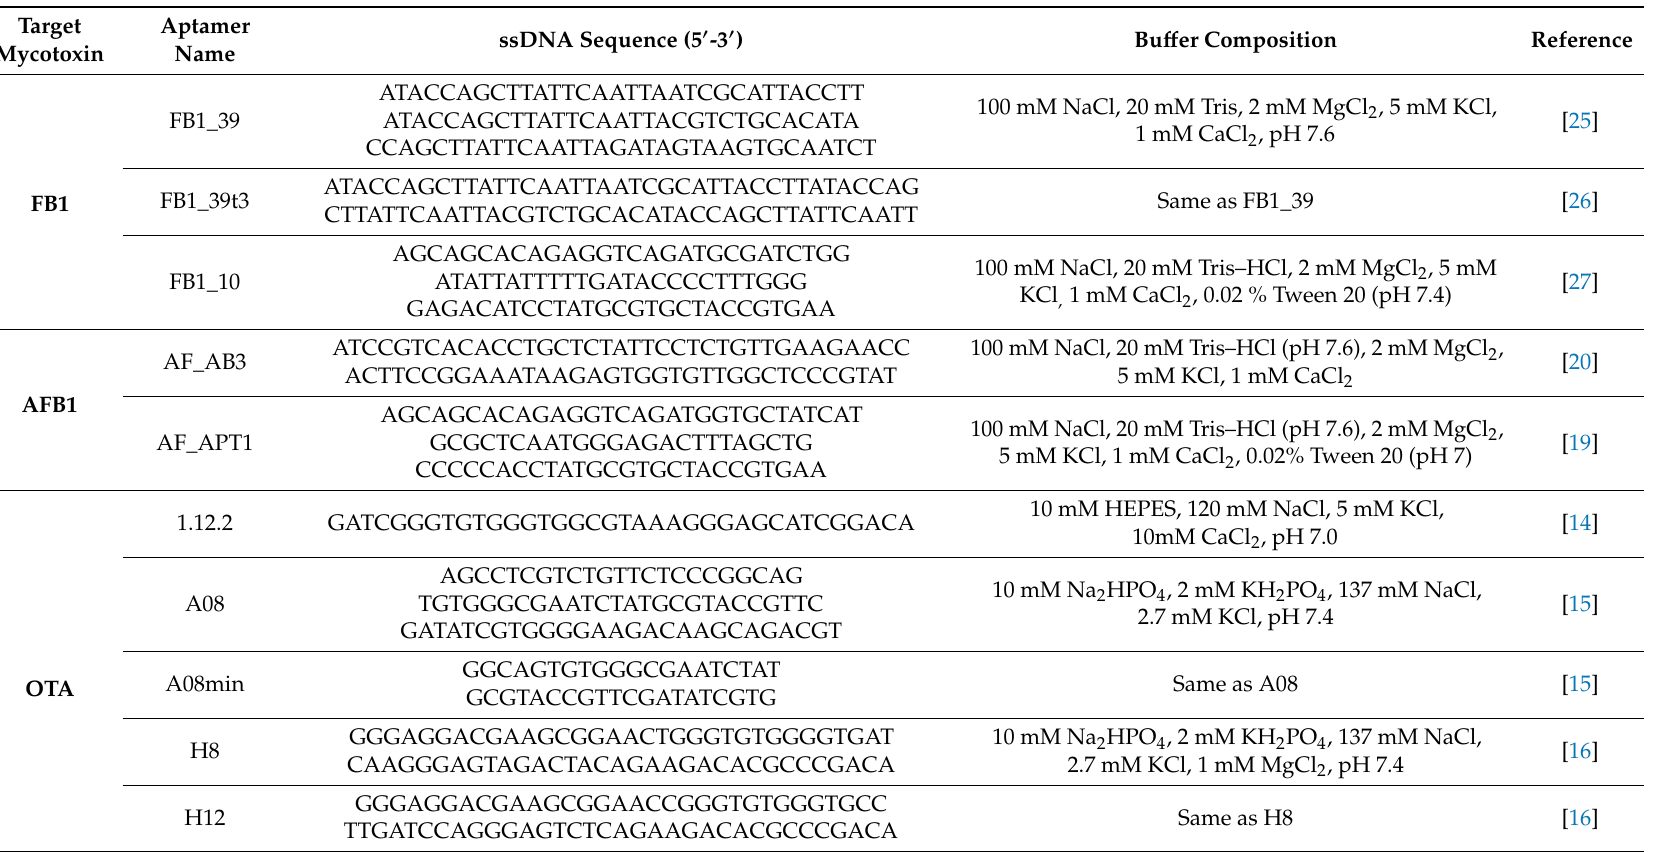
Table 1. Fumonisin B1 (FB1), aflatoxin B1 (AFB1) and ochratoxin A (OTA) aptamers and relative bu ff er